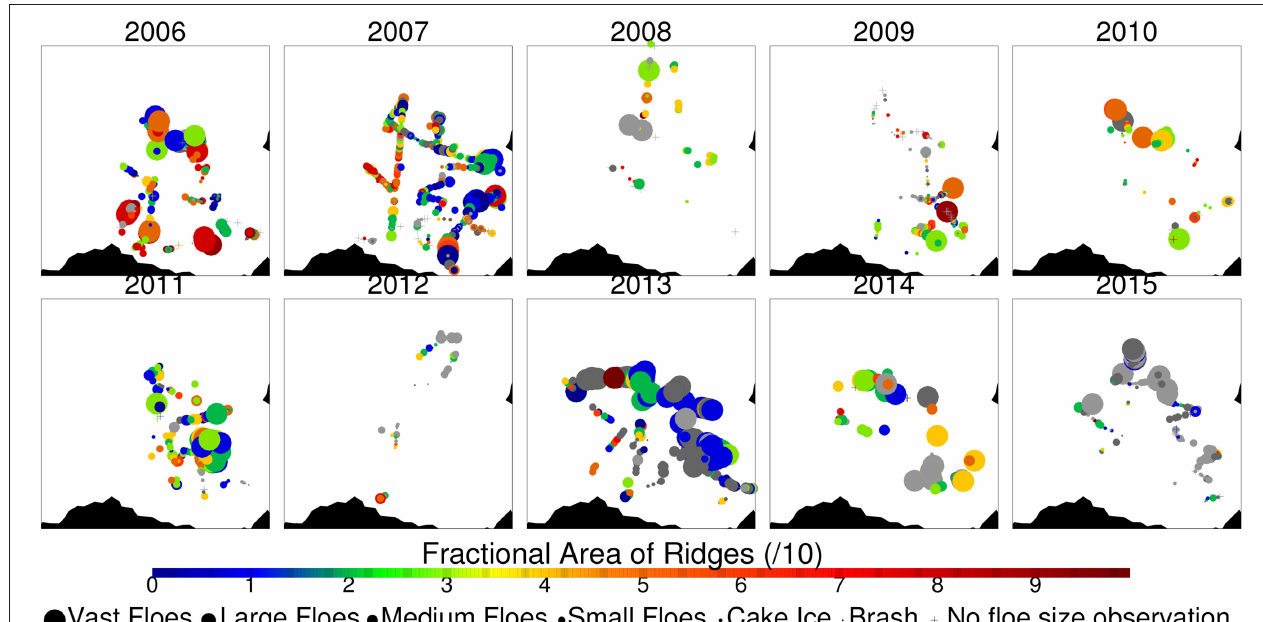
FIGURE 5 | Area of ridges on multi-year ice is shown in color. Gray colored circles do not have this topographic information in the observation record. The symbol size reflects the floe size of the multi-year ice. Multi-year ice for which no floe size information is available are shown as a cross.